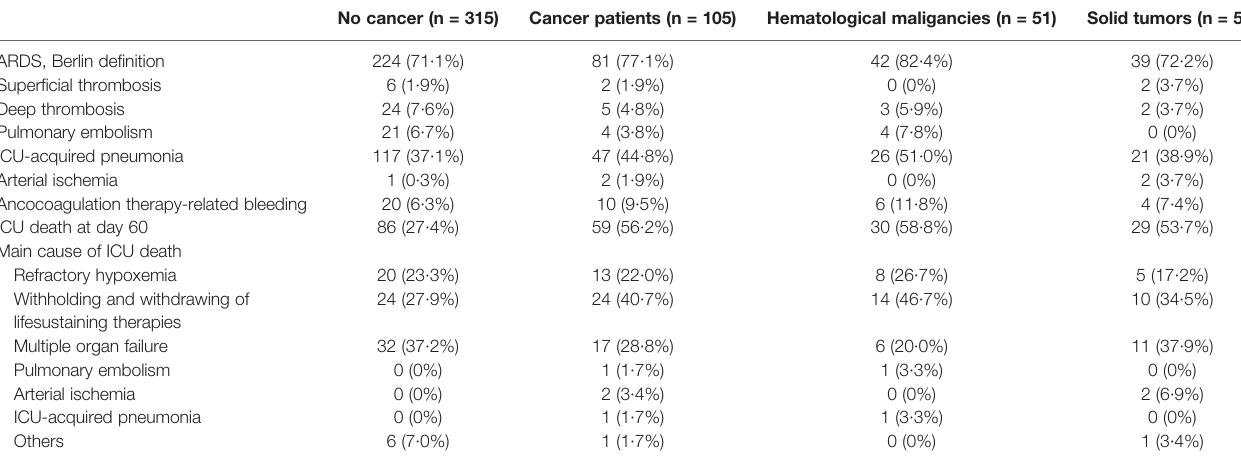
TABLE 4 | Outcome of patients during their ICU